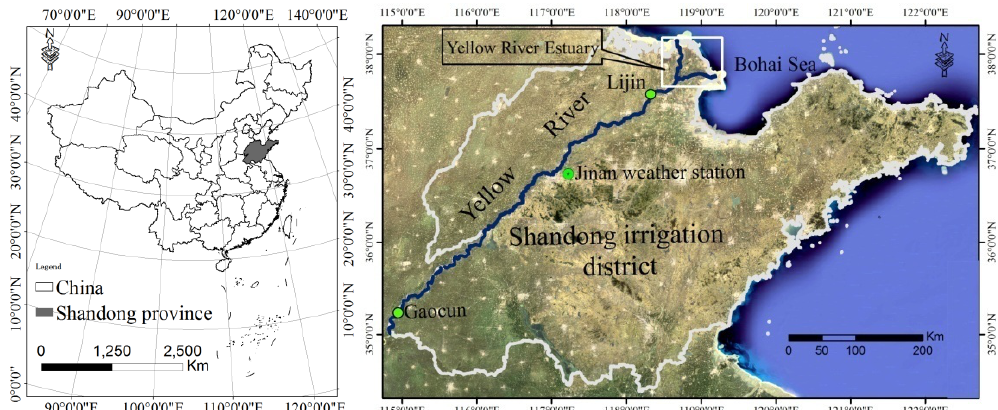
Figure 4 Fig. 4. Location of the Yellow River estuary and the Shandong irrigation district in China.